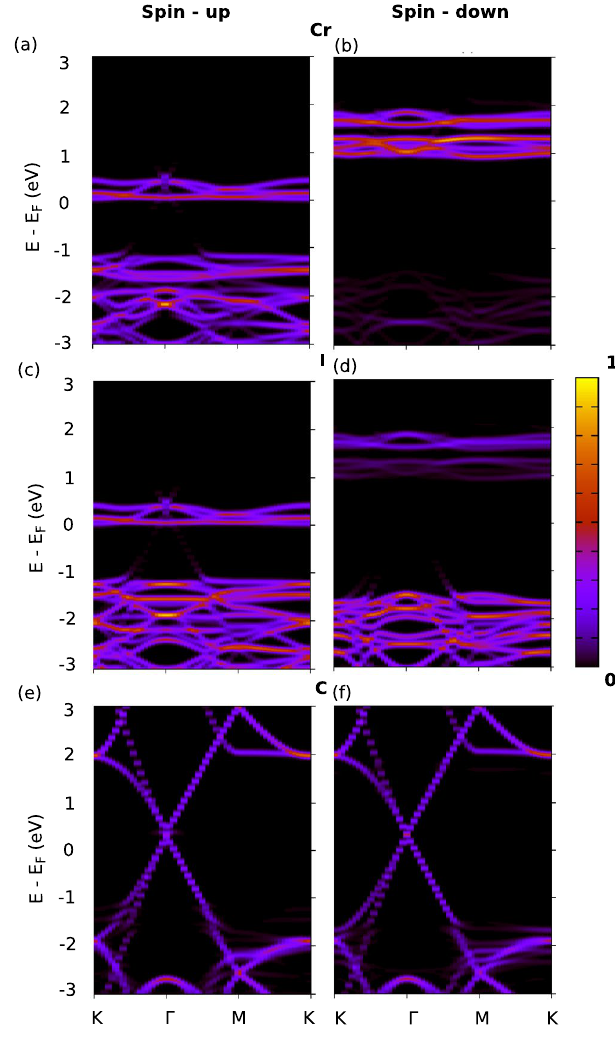
Figure 5. The k-resolved DOS projected on individual atom types (KDOS(k,E)) is shown for ( a , b ) The spin up and spin down bands for 3:1 G/CrI 3 projected on Cr states respectively. ( c , d ) The spin up and spin down bands projected on I respectively. ( e , f ) The spin up and spin down bands projected on graphene respectively. The color scale has been normalized with respect to the maximum value of the state localized around their respective atom